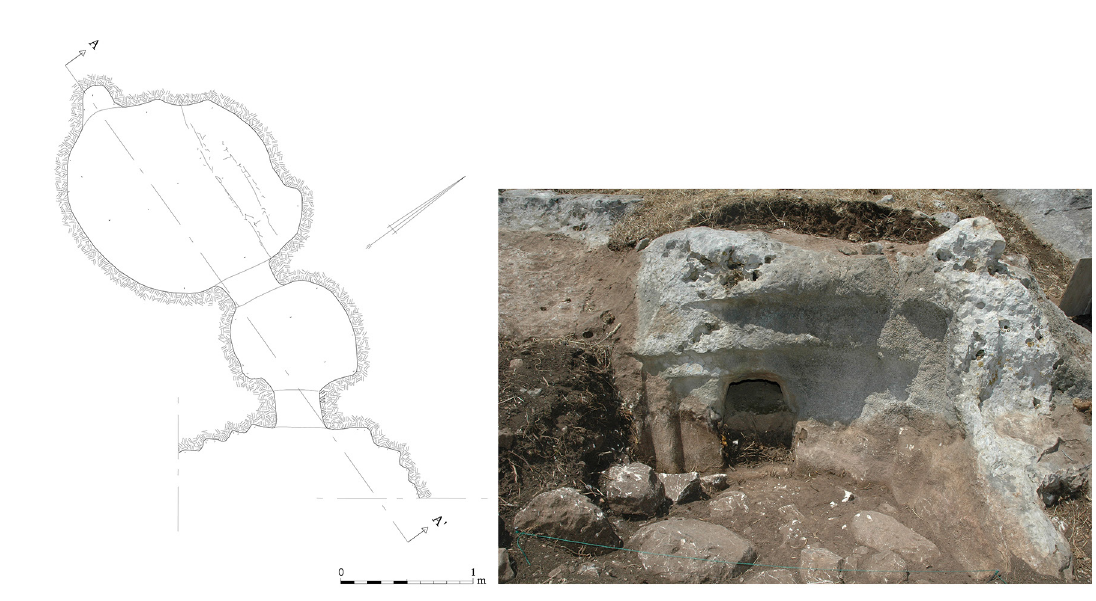
Figure 2. Tomb 69. Plan and framed